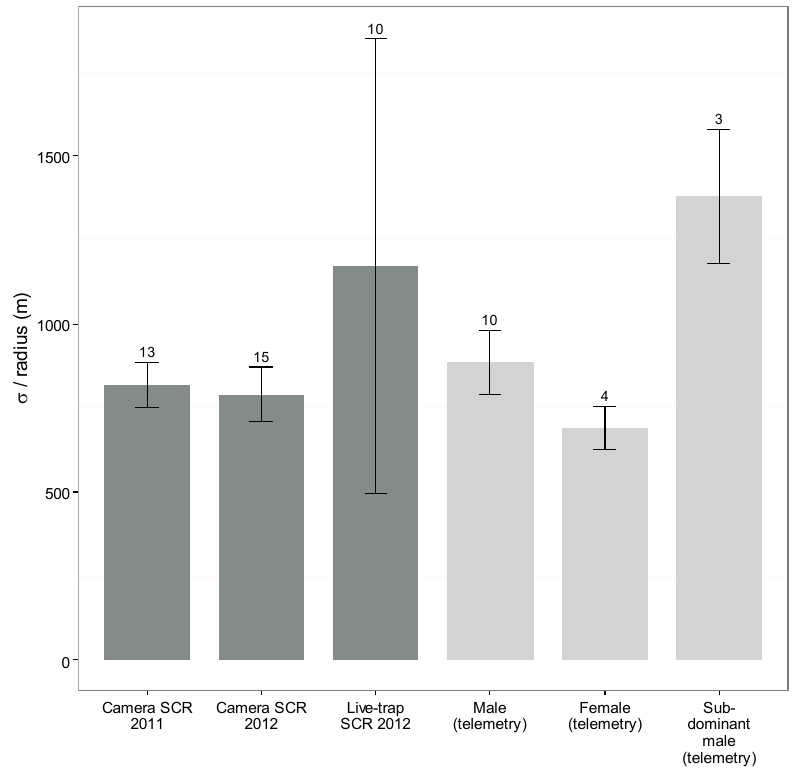
Figure 5. Mean (± SE) σ values (m) from SCR density estimates, and mean (± SE) 95% MCP home ˘ SE) σ values (m) from SCR density estimates, and mean ( ˘ SE) 95% MCP home range radius (m) for male, female, and sub ‐ dominant male radio ‐ collared martens over two winters Figure 5. Mean ( range radius (m) for male, female, and sub-dominant male radio-collared martens over two winters of camera- and live-trapping, and radio telemetry monitoring. Note: Sample size is listed above SE